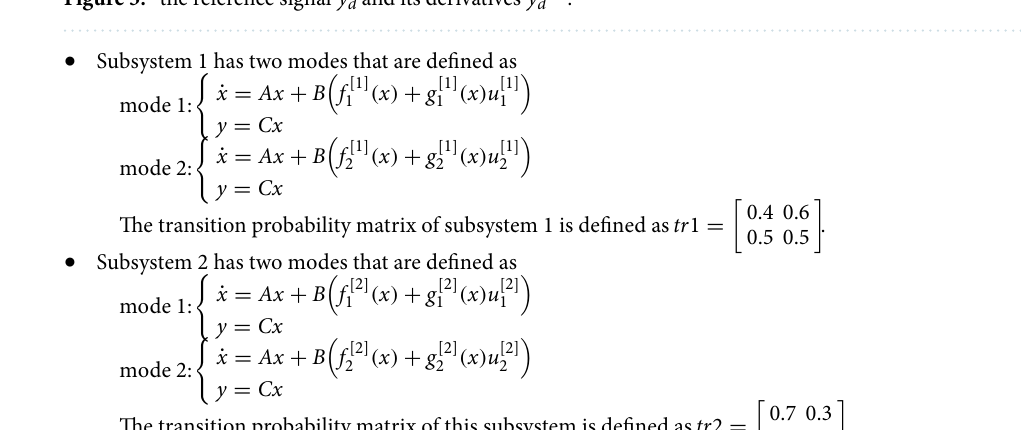
Figure 3. the reference signal y d and its derivatives y d ( 1 )